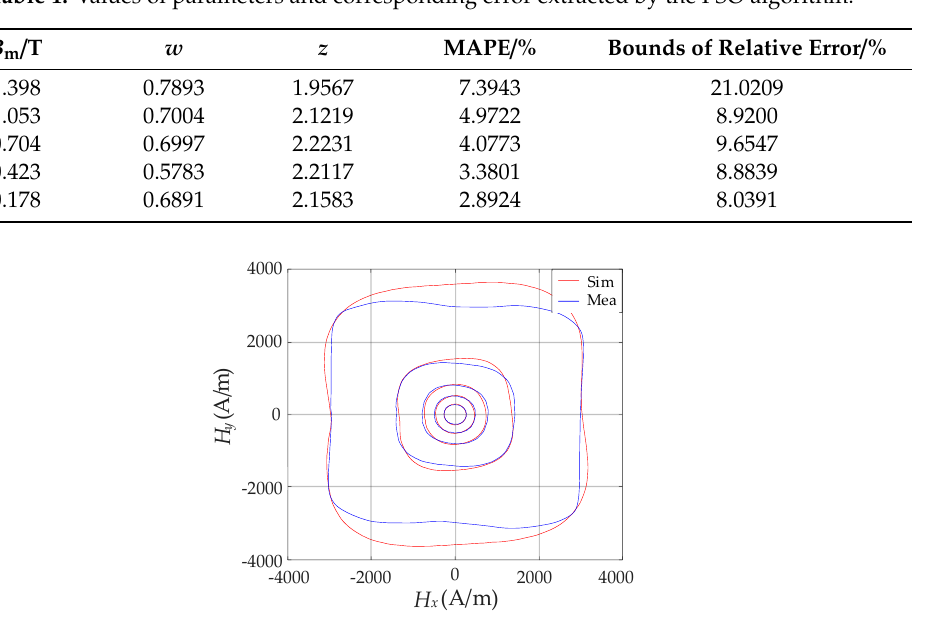
Figure 11. Comparison between measured H and simulated H based on the PSO algorithm.